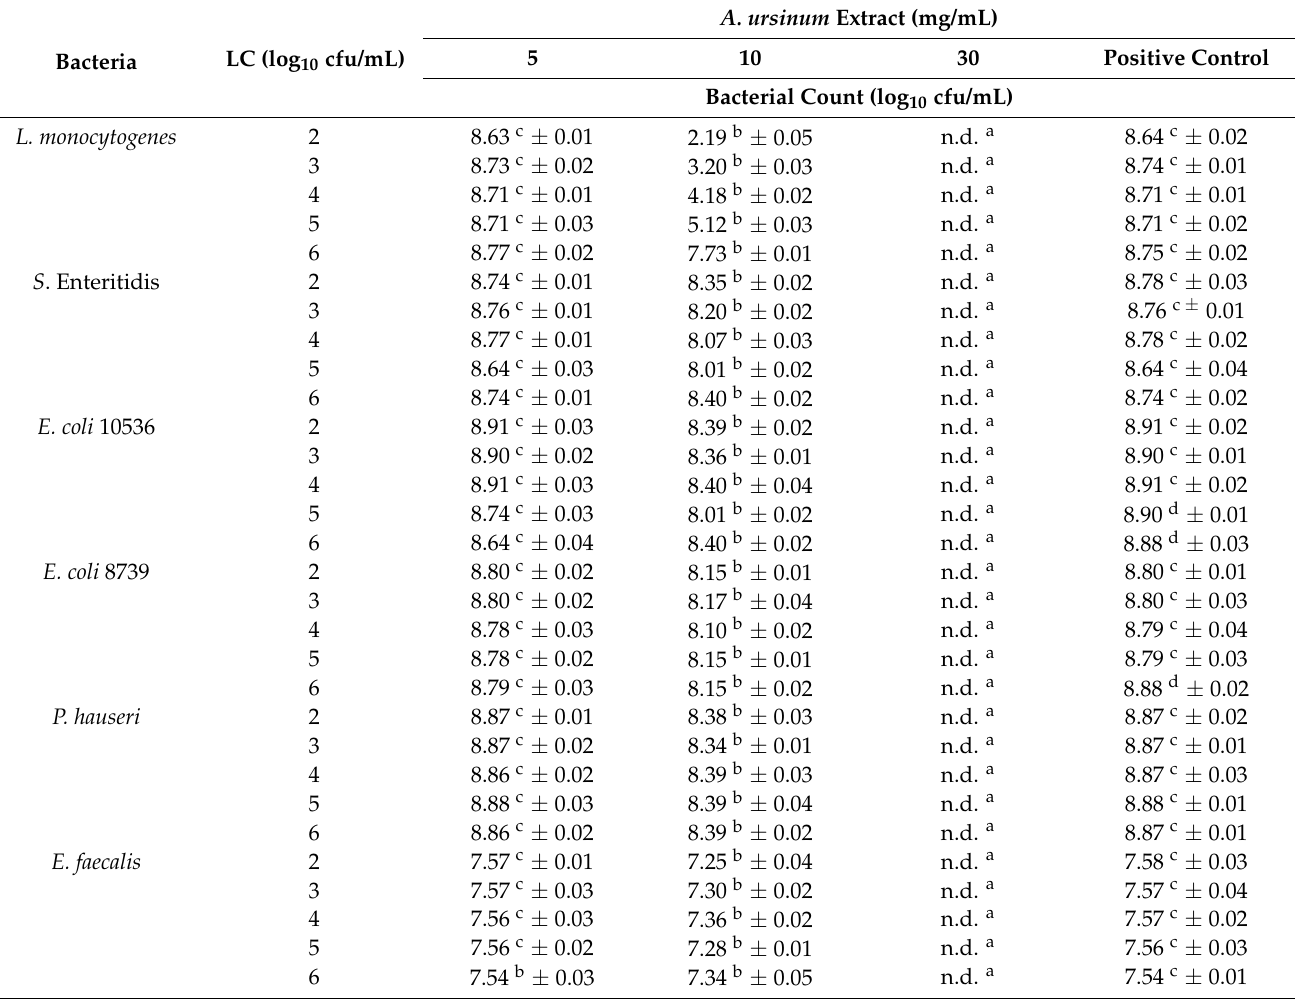
Table 2. Antimicrobial activity of A. ursinum extract at concentrations of 5, 10 and 30